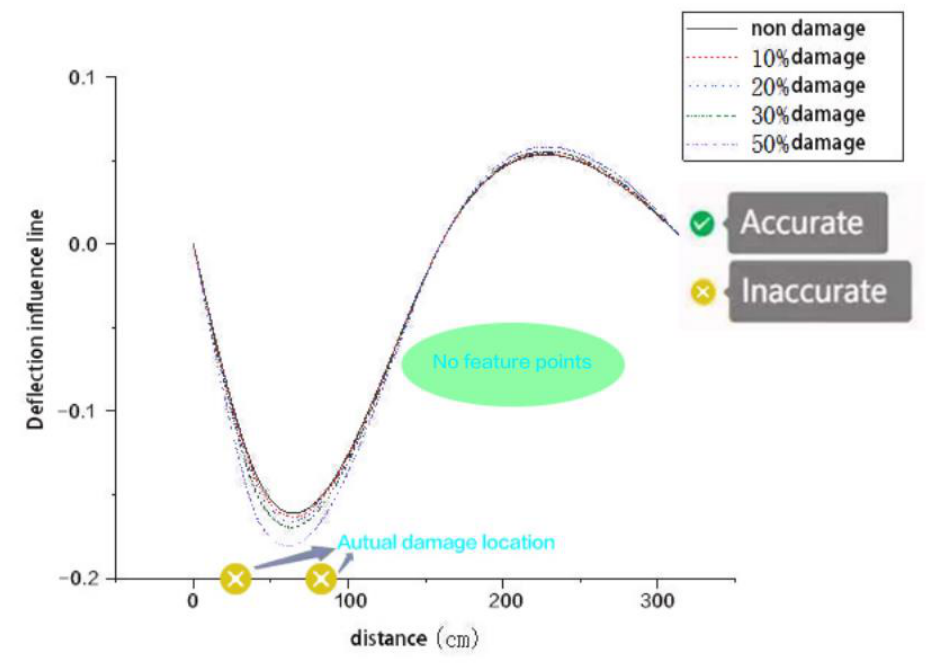
Figure 10. Deflection influence line of 1/4 determining point of the 1st span following work condition 2 (1-5).